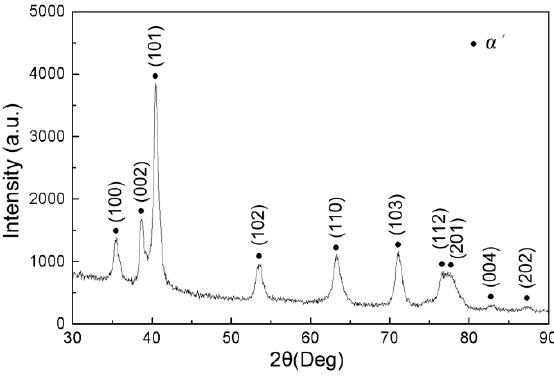
Figure 7. XRD pattern of Ti6Al4V deposited coating.